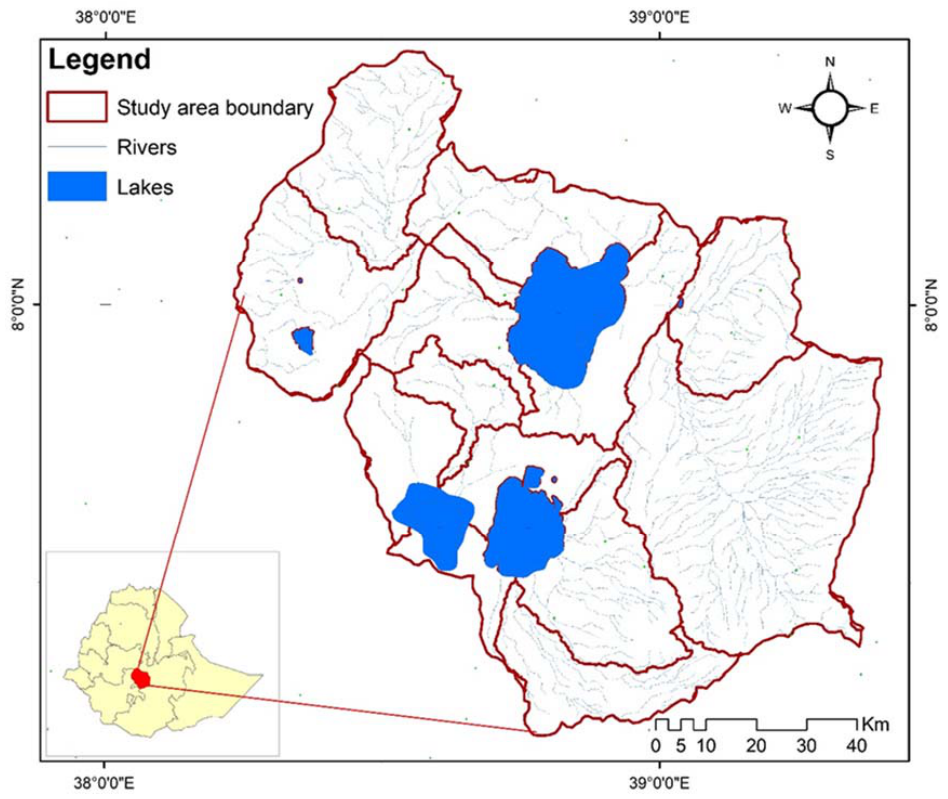
Figure 1. Map of the study area.